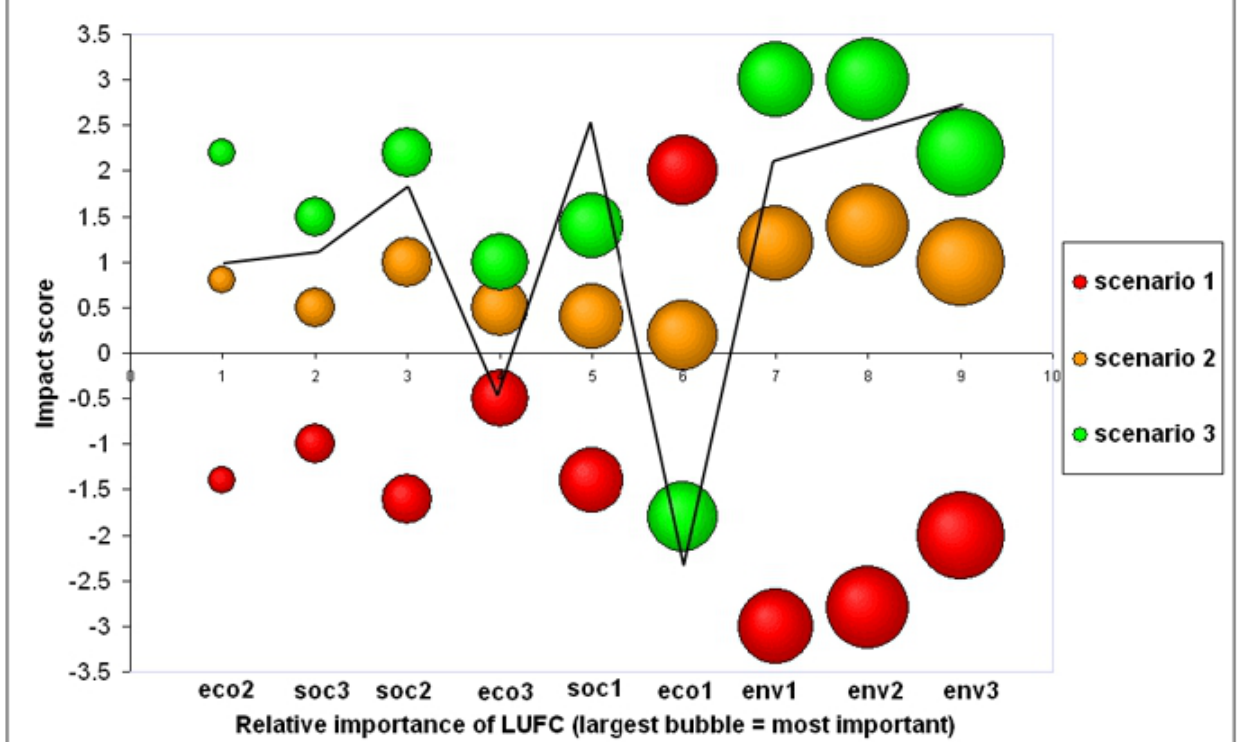
Fig. 2 . Summary presentation of FoPIA results - SIA of biodiversity policy scenarios in Malta. Bubble size denotes relative importance of LUFC. Trend line denotes sustainability limit for